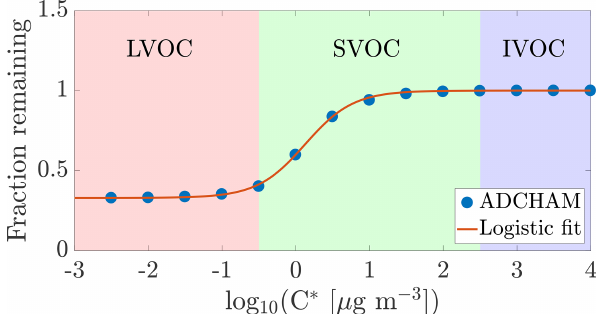
Figure 3. Modelled fraction remaining vs. the logarithm of satura- tion concentration from the ADCHAM model for experiment num- ber eight (Table A1). In addition to the discrete data points repre- senting model compounds in ADCHAM (Sect. 2.5), a logistic fit to + 0 . 33, is shown. Shad- them, with the formula y = 1 − 0 . 33 1 + e − 3 . 0 (x − 0 . 13 ) ing according to the volatility classes by Donahue et al.